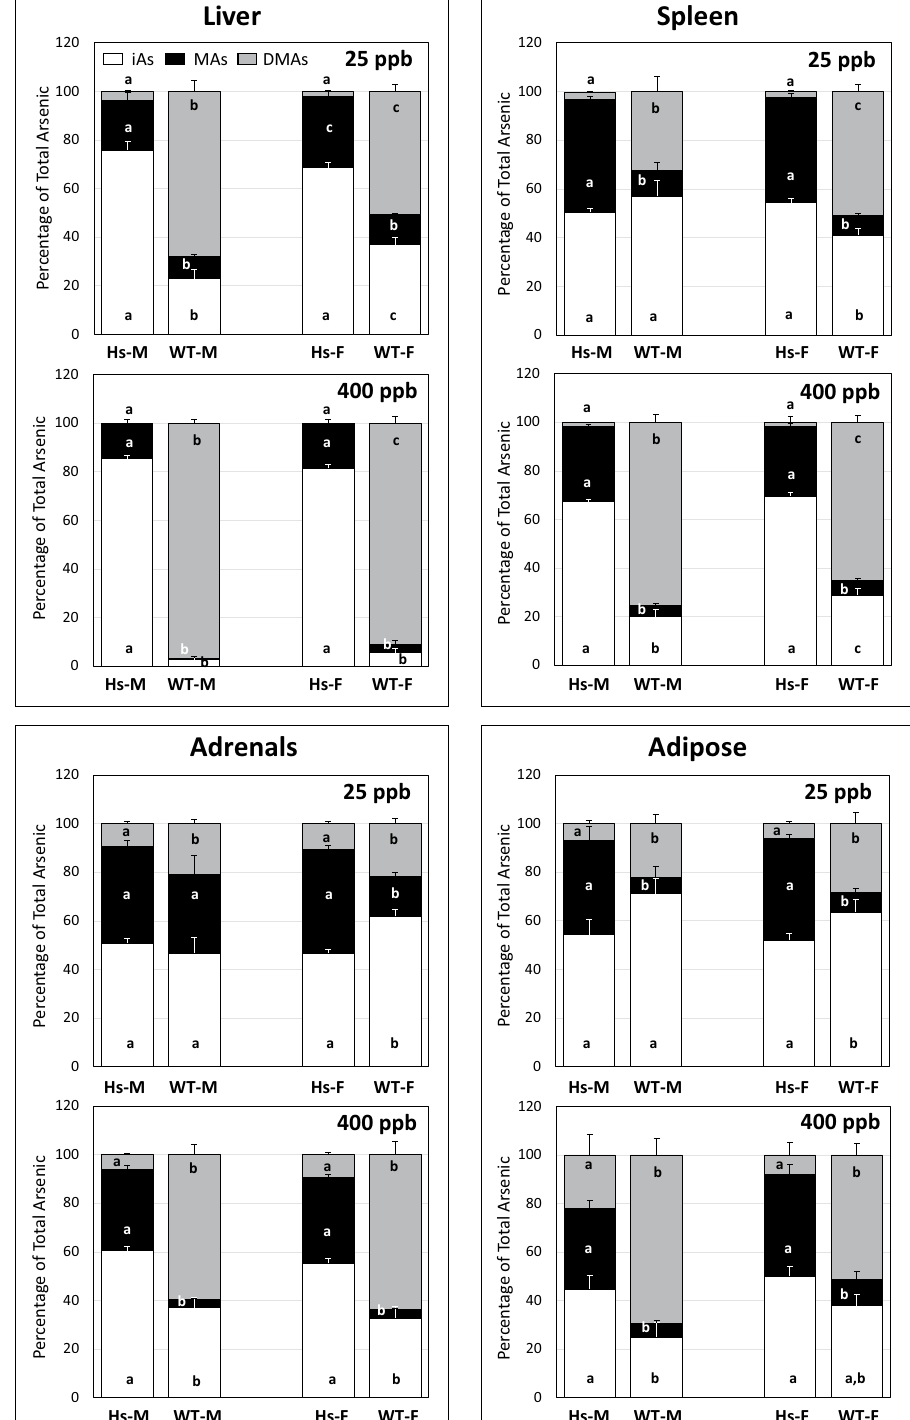
Figure 6. Percentages of total arsenic represented by inorganic arsenic (iAs), methylarsenic (MAs), and dimethylarsenic (DMAs) in liver, spleen, adrenals and adipose tissue of humanized (Hs) and wild-type (WT) male (M) and female (F) mice after 4-week exposure to 25-ppb or 400-ppb of inorganic arsenic in drinking water: The tissues of Hs mice with highest percentages of iAs and the corresponding tissues of WT mice are shown. Each bar and whisker represent mean and SEM value, respectively. For 25-ppb exposure, N = 6 for Hs males and WT males, and N = 8 for Hs females and WT females. For 400-ppb exposure, N = 7 and 8 for Hs males and WT males, respectively, and N = 10 and 11 for Hs females and WT females, respectively. For each arsenic species, values marked with different letters are significantly different (p <